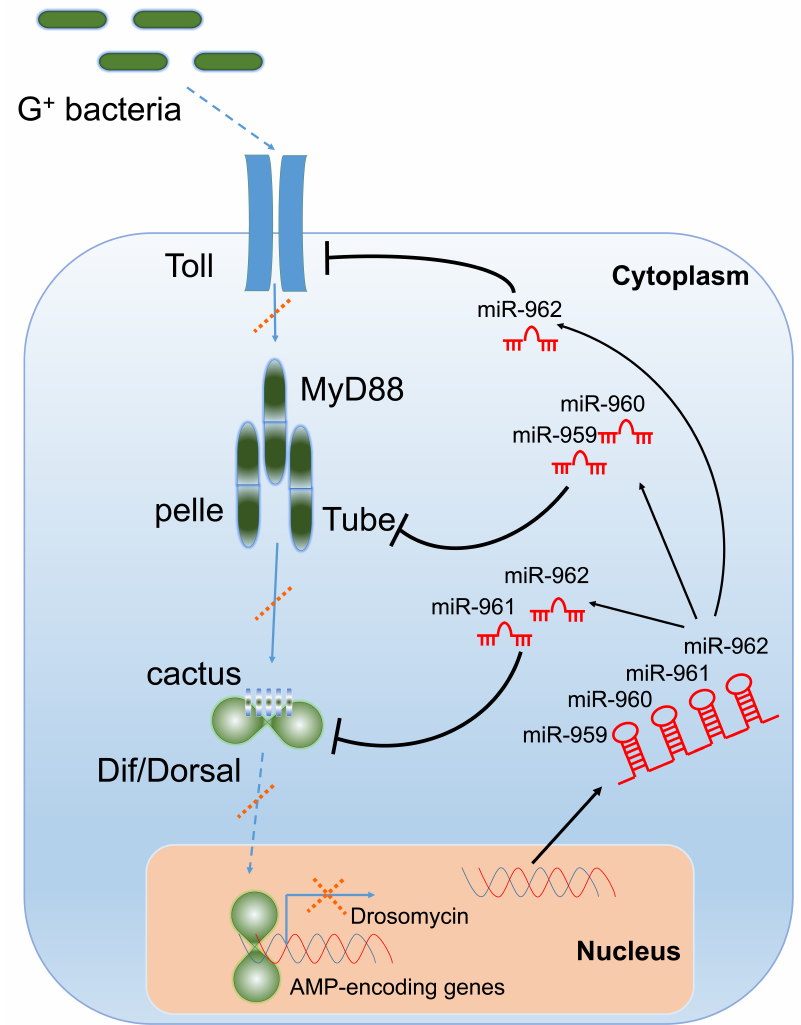
Figure 8. A proposed model. Our results suggested a model in which the miR-959–962 cluster members (red) play a synergistic regulatory function on the Toll innate immunity via fine-tuning the different layers of Toll signal transduction. MiR-959 and miR-960 target the 3 (cid:48) UTR of tube ; miR-961 and miR-962 target the 3 (cid:48) UTR of dl ; and miR-962 also target the 3 (cid:48) UTR of Toll